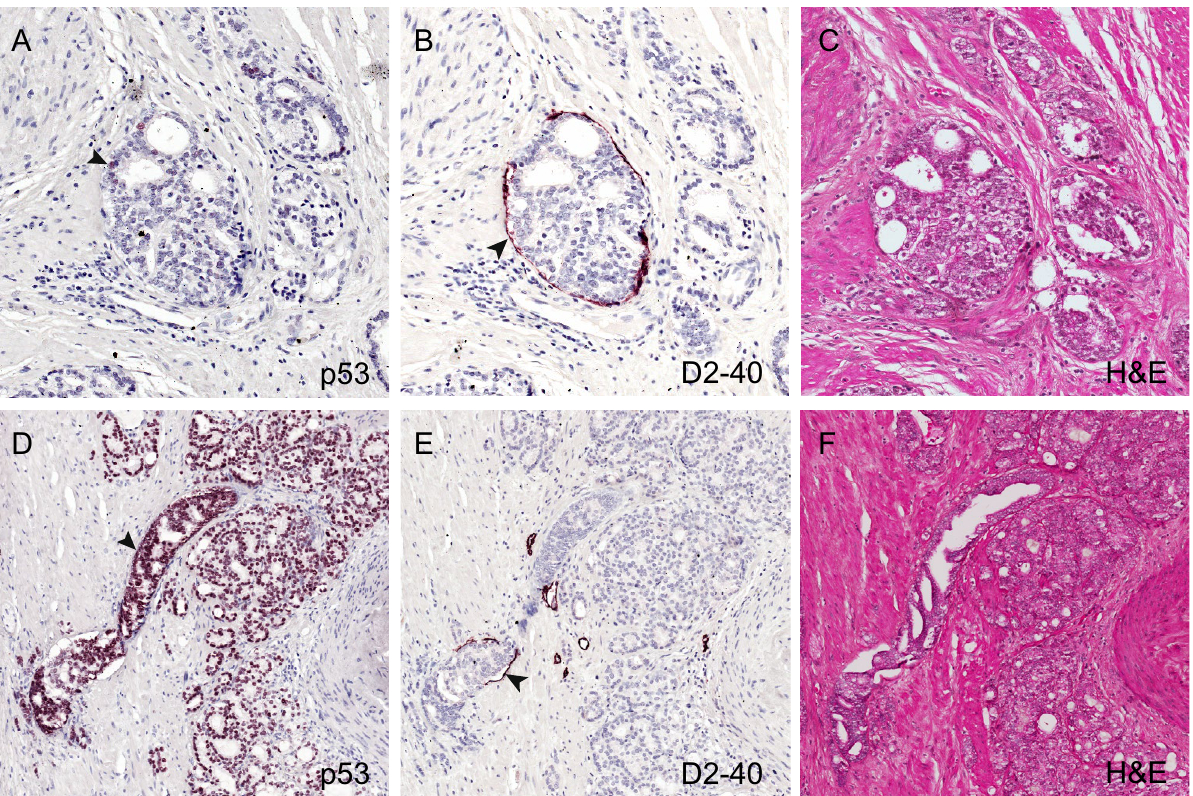
Figure 2. Representative p53 and lymphovascular staining in index tumors. p53 staining was detected at variable degrees of intensity between 1 and 5% in single cells ( A ) and in clusters of cells with greater than 5% ( D ) in relation to the area of the index tumor. The infiltration of tumor cells into lymphovascular spaces was confirmed by D2-40 IHC staining ( B , E ). The corresponding ( H & E ) images are shown in panel ( C ) and ( F ). Images were captured at 10X magnification. Arrowhead indicates individual cells stained by the p53 and D2-40 monoclonal